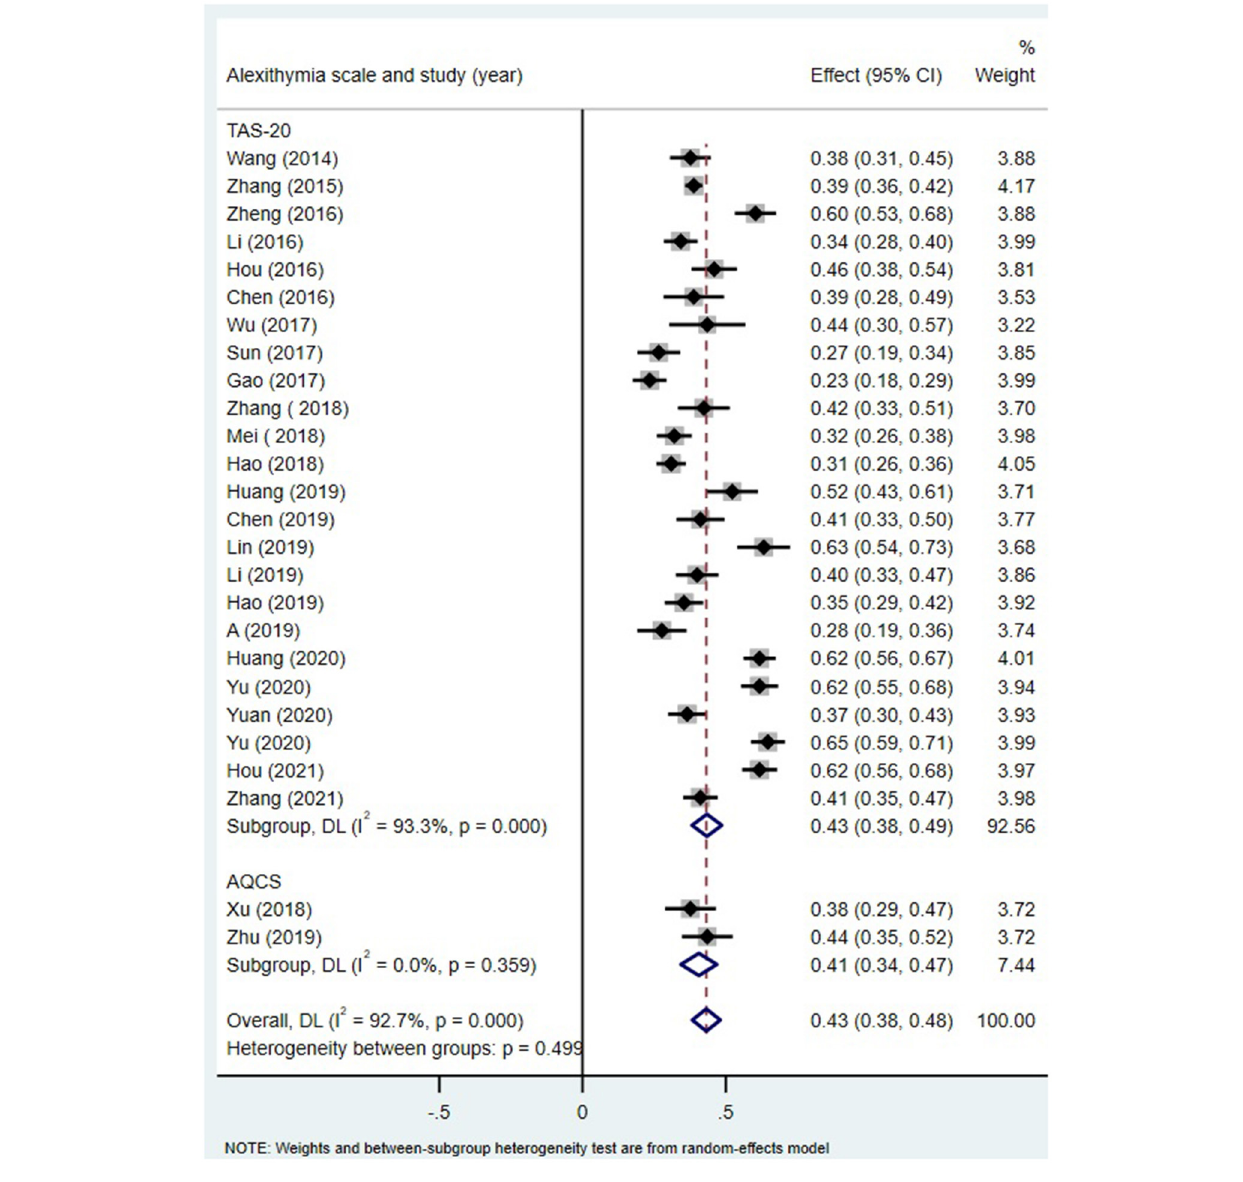
FIGURE 5 | MPA and alexithymia: an analysis of the moderating effects of the alexithymia measurement